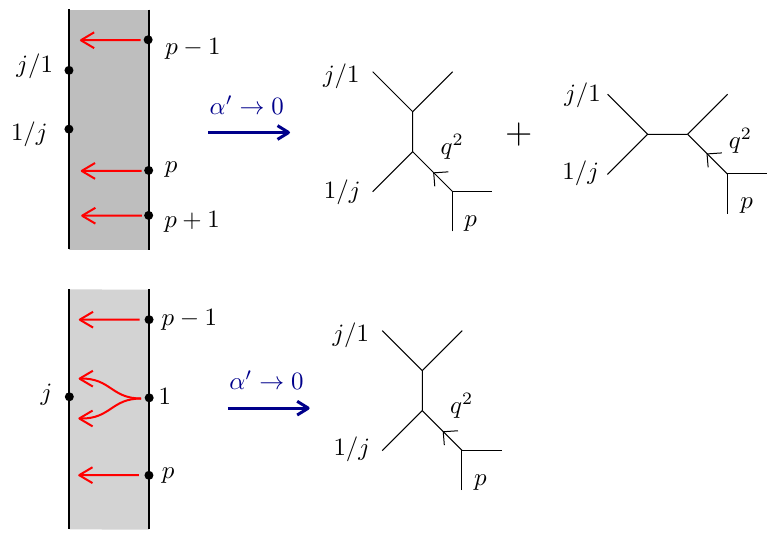
Figure 11 . How graphs participating on a particular BCJ triple are generated. Top: planar graphs contribute to tree and box-type graphs. Bottom: non-planar graphs only contributes to